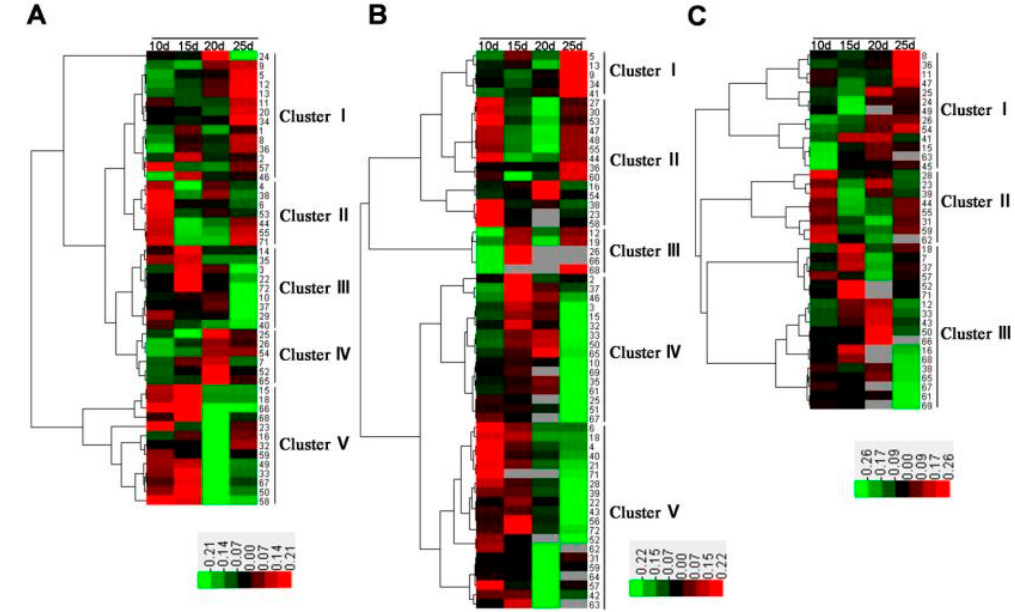
Figure 6. Hierarchical cluster analysis of identified differentially accumulated protein spots in wheat flag leaves from 10, 15, 20, and 25 days post-anthesis under ( A ) water-deficit, ( B ) high-nitrogen fertilizer, and ( C ) combined treatments.